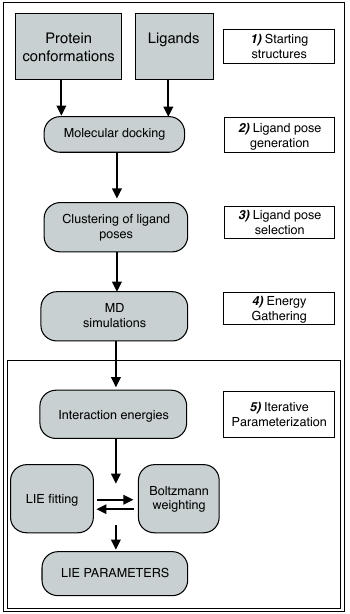
Figure 1. Workflow for training of iterative LIE models. In the current work, 2 protein conformations and 9 training and 8 test ligands were used to generate maximally 600 docked poses per ligand, from which 3 poses per ligand and per protein conformation were selected to start